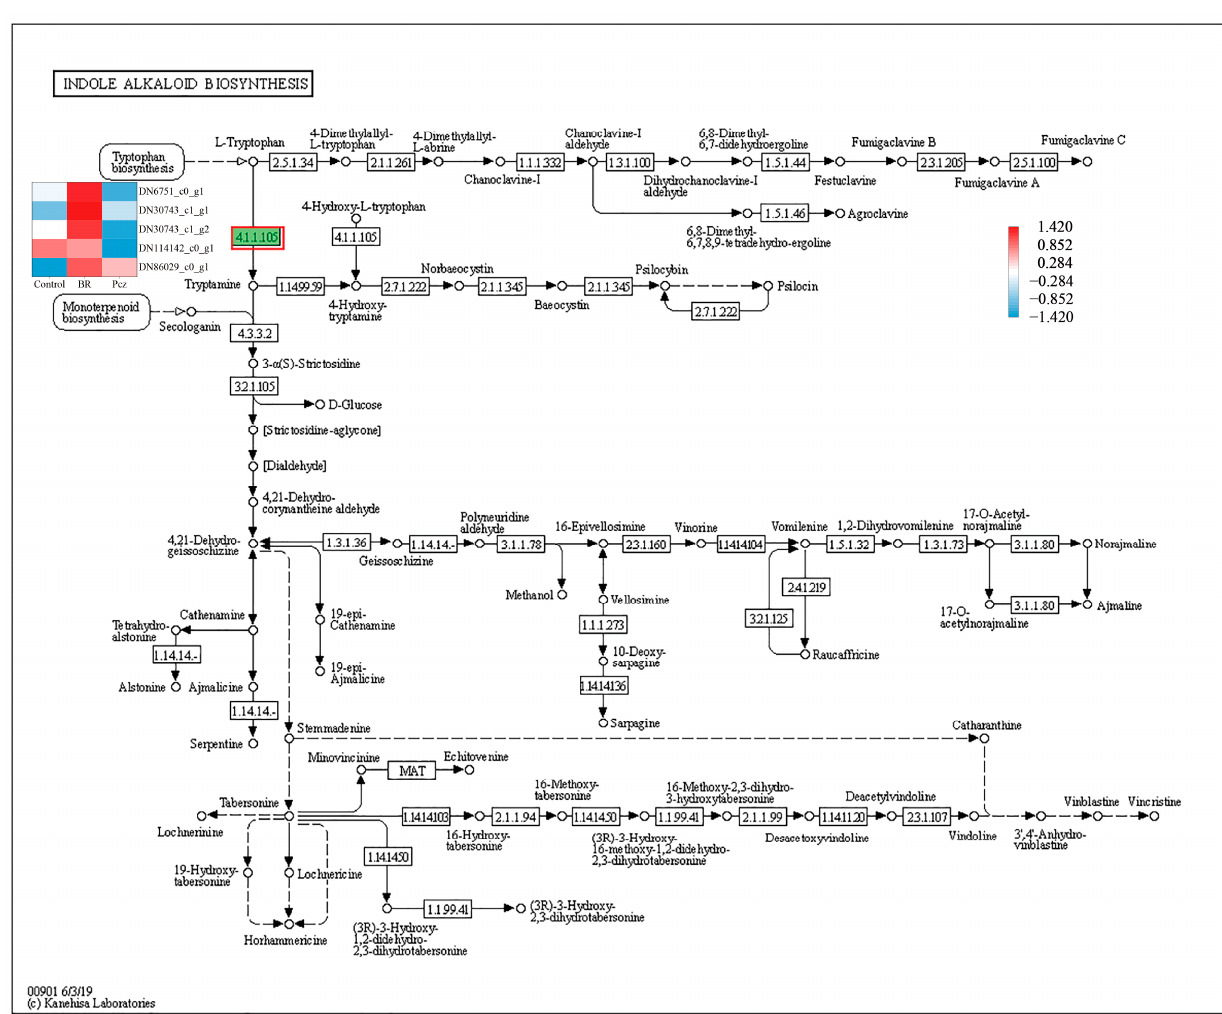
Figure 5. Differential expression levels of unigenes related to indole alkaloid biosynthesis identified by KEGG annotation. Changes in expression level are represented by a change in color; blue indicates a lower expression level, whereas red indicates a higher expression level. All data shown reflect the average mean of three biological replicates.